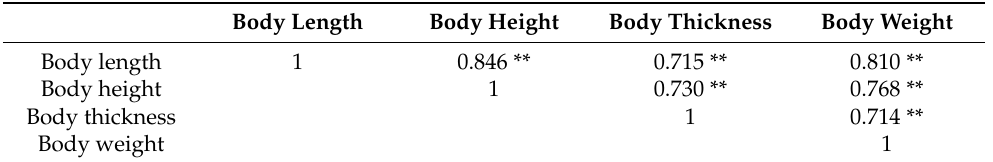
Table 1. Pairwise correlation for all 4 growth-related traits in Yellow River carp at 5–17 months after hatching.